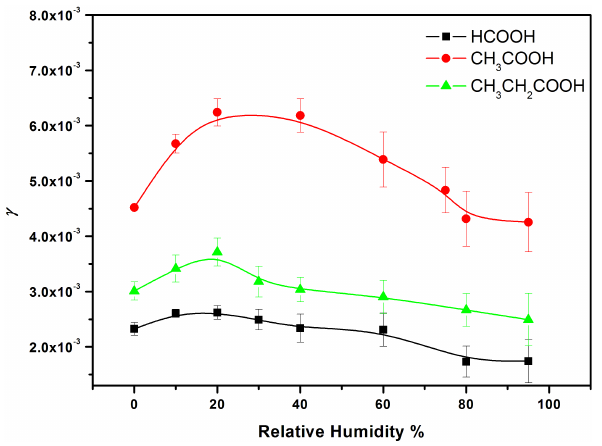
Fig. 7. Uptake coefficients for the reactions of alumina with car- boxylic acids as a function of